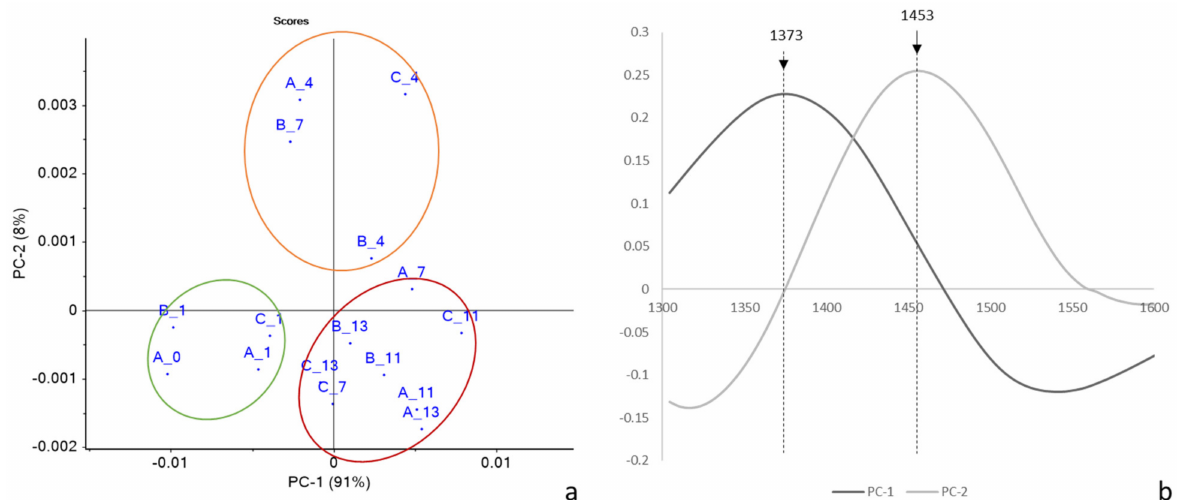
Figure 6. PCA score ( a ) and loading ( b ) plots of pre-treated NIR spectra of rocket salads of Trial 1 (each point corresponded to the mean spectra for each checkpoint).